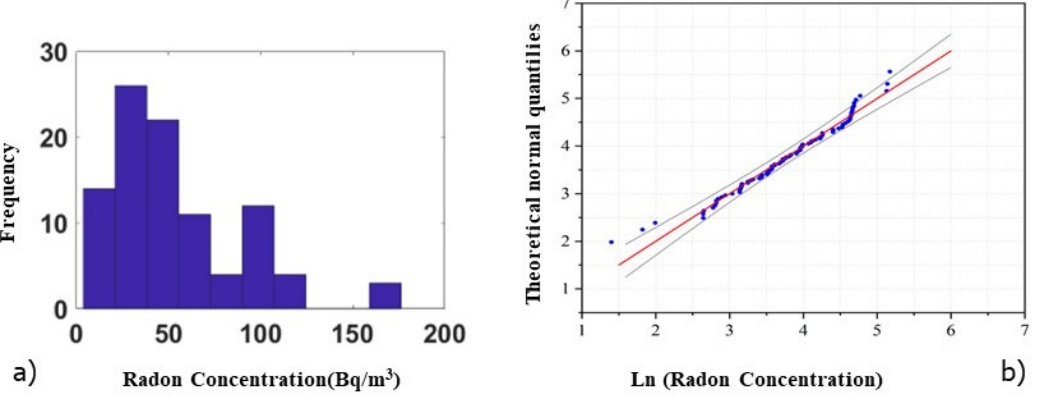
Figure 4. ( a ) Frequency distribution of indoor radon concentrations measured in dwellings in Kpong; ( b ) Q-norm plot of natural log-transformed radon concentration, reference line in red, lower, and upper percentile in black.